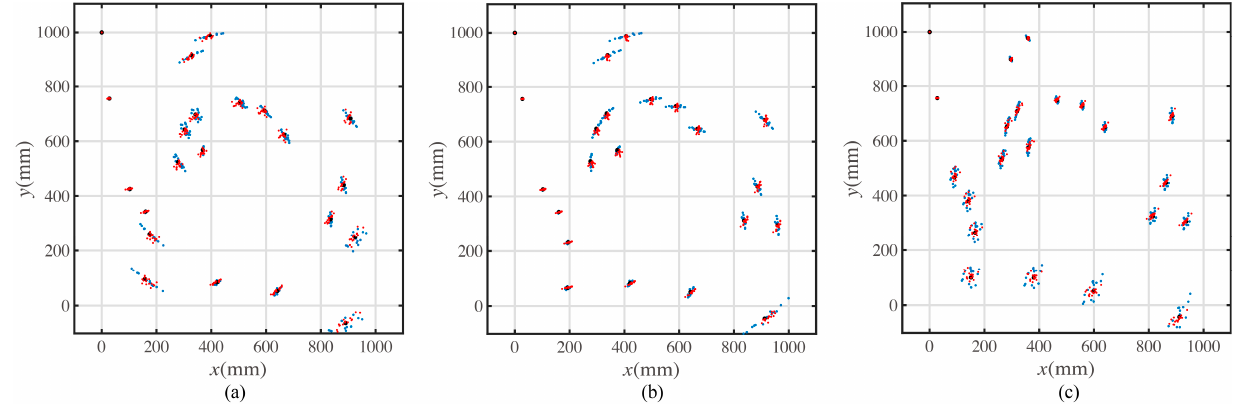
Figure 16. Position scatters of simulated results and experimental results. ( a ) The simulated and experimental positions for mobile robot moving along the minimum rotation angle path. ( b ) The simulated and experimental positions for mobile robot moving along the minimum average position error path. ( c ) The simulated and experimental positions for mobile robot moving along the minimum forward moving distance path.